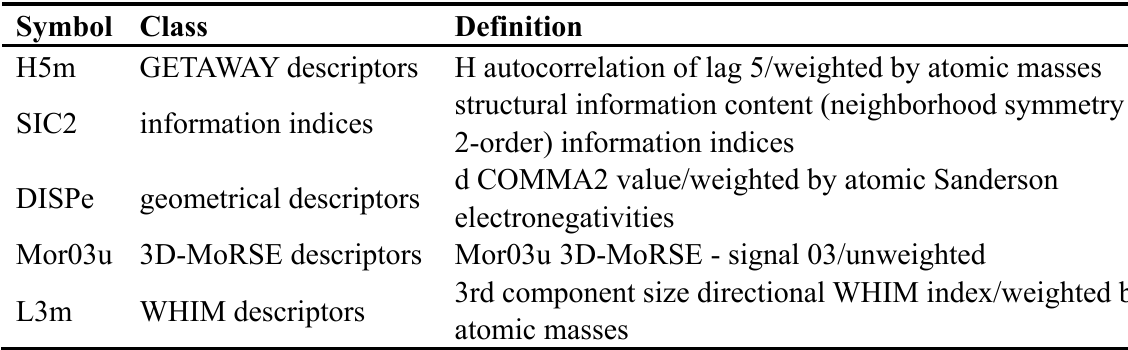
Table 3. The molecular descriptors involved in the ERM-MLR models and their corresponding definition.